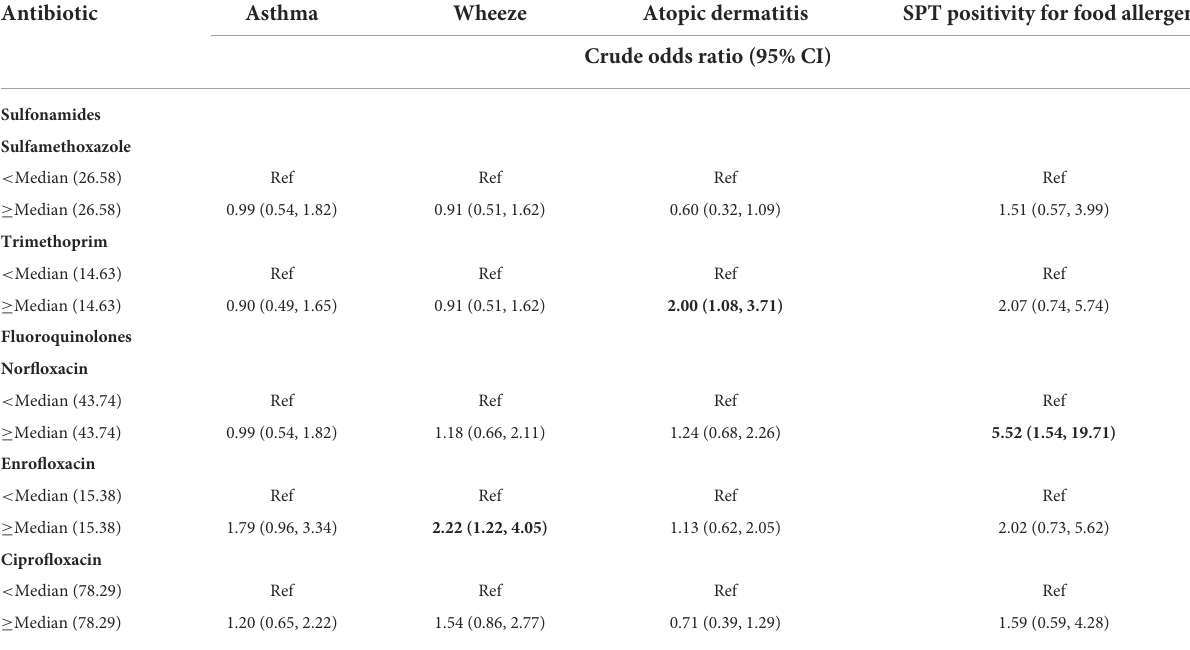
TABLE 4 Associations between maternal urinary antibiotic concentrations (ng/g creatinine) and allergic diseases and skin prick test positivity for food allergens (five antibiotics with detection frequency above 50%). Antibiotic Asthma Wheeze Atopic dermatitis SPT positivity for food allergens Crude odds ratio (95% CI)